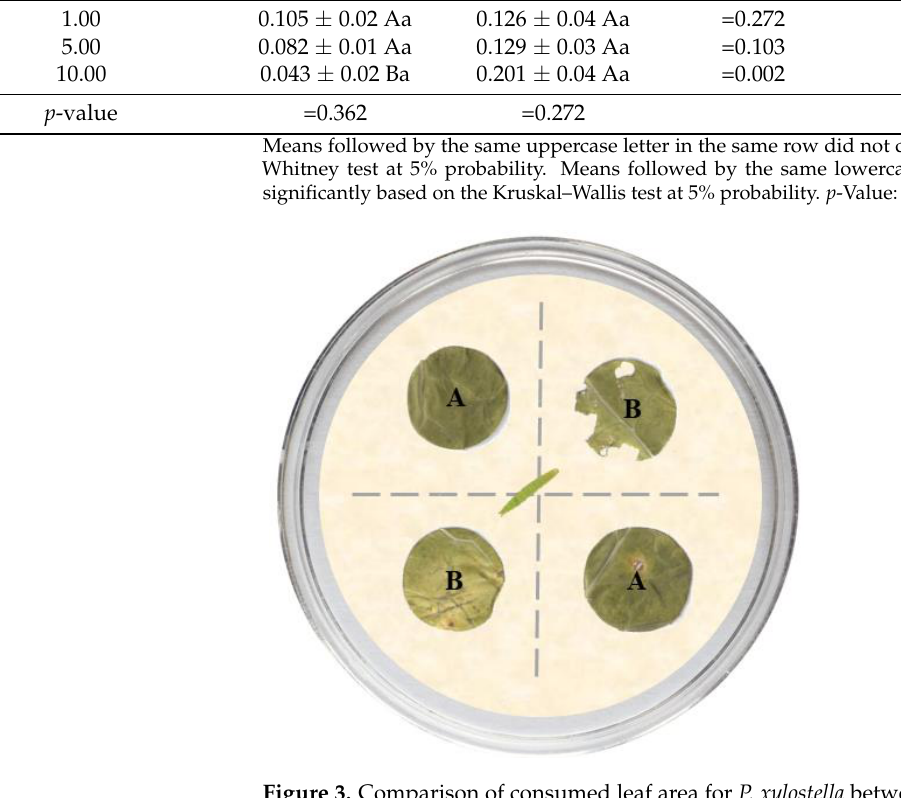
Table 5. Oviposition suppression index (OSI) of Plutella xylostella according to the number of eggs deposited on discs treated with distilled water (control) and with botanical extracts of Miconia albi- cans .